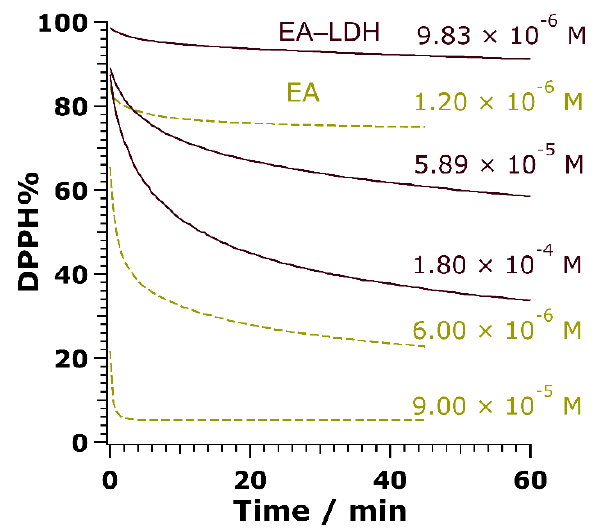
Figure 5. Changes in DPPH concentration in the presence of EA (dashed lines) and EA-LDH (full lines) as a function of the reaction time at 3 different initial antioxidant doses.